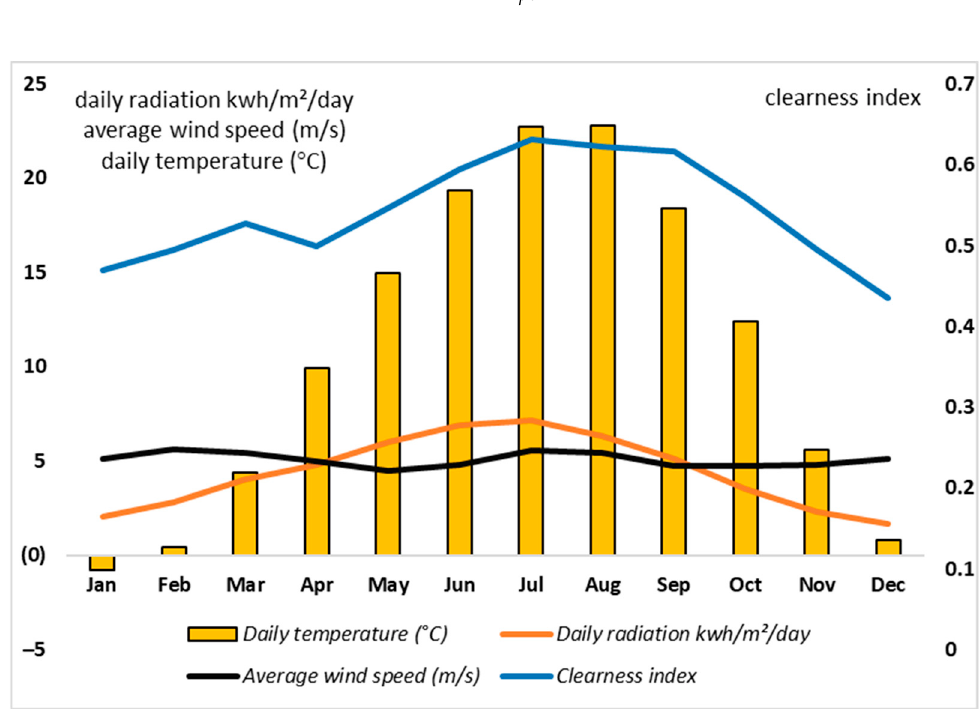
Figure 2. Realistic renewable resources data of the selected area.